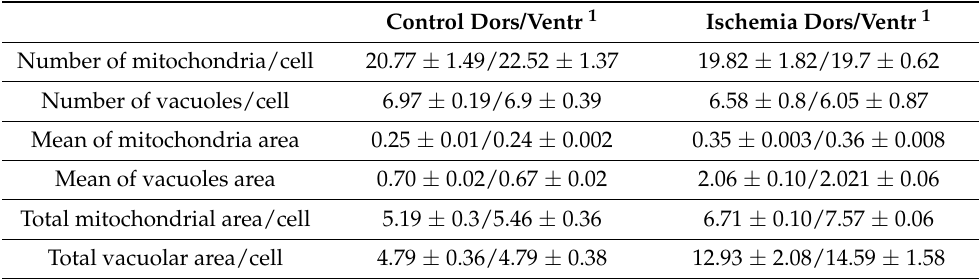
Table 1. Ultrastructural morphometry of HSP70 within whole cell